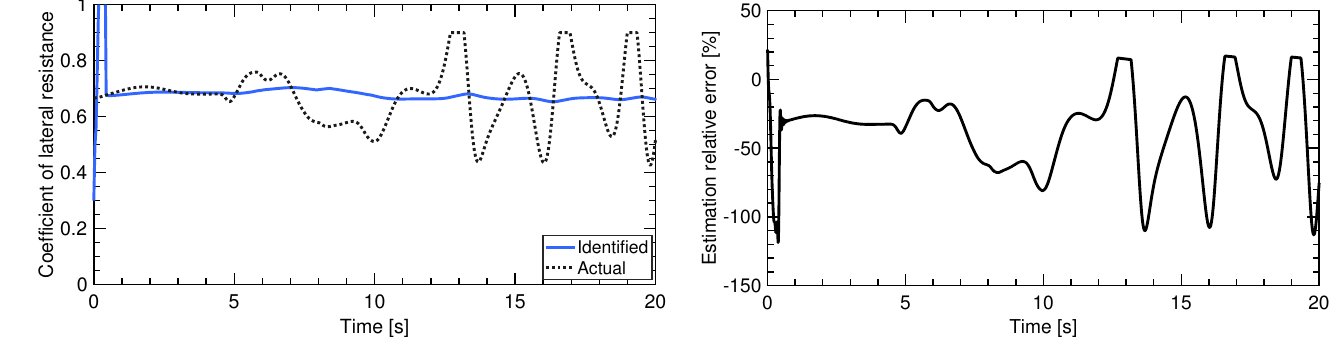
Figure 31. Lateral resistance coefficient: identified value ( left ) and relative error ( right ).